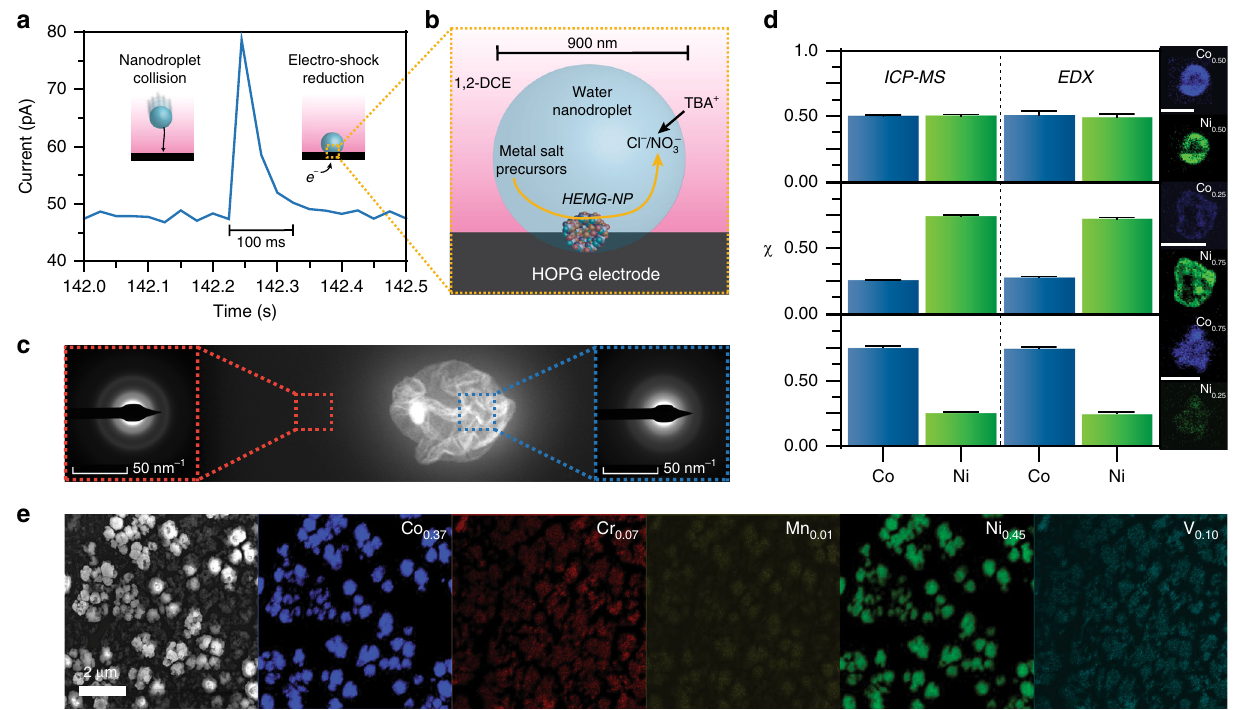
Fig. 1 Nanodroplet-mediated electrodeposition overview for controlling NP stoichiometry and microstructure. a Current transient corresponding to the collision of a single nanodroplet onto a carbon fi ber UME ( r UME = 4 μ m) biased at − 0.4 V vs. Ag/AgCl. Nanodroplet contents are fully (>98%) reduced within 100 ms, facilitating disordered co-deposition of various metal precursors. b Representation of a nanodroplet collision event highlighting the rapid NP formation at the water/substrate interface and the charge balance ensured by the transfer of TBA + across the oil/water interface. c An amorphous microstructure is con fi rmed by a lack of crystallinity at high resolution and the presence of diffuse rings on the SAED pattern. d Correlated ICP-MS and EDX results on Co0.5Ni0.5, Co0.25Ni0.75, and Co0.75Ni0.25 MG-NPs con fi rming precise control over NP stoichiometry. e Alloy fi lm electrodeposited from aqueous solution of equimolar metal salt precursors demonstrating phase and stoichiometric heterogeneity. Source data for panels a and d are provided